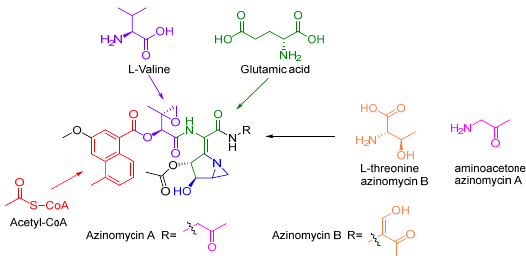
Figure 12. Proposed mechanism of DNA cross-linking by azinomycins.